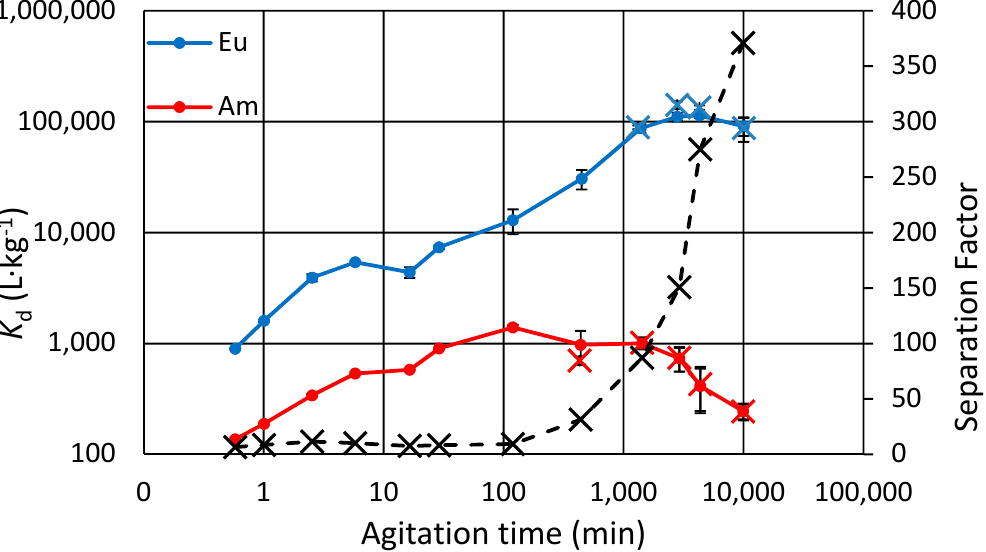
Figure 3. Distribution coefficients for ZrP for Eu(III) and Am(III) in separate solutions of nitric acid (pH 1.5) containing 0.1 mol · L − 1 NaNO 3 as a function of equilibrating time. Separation factor (SF) is calculated as K d (Eu): K d (Am).